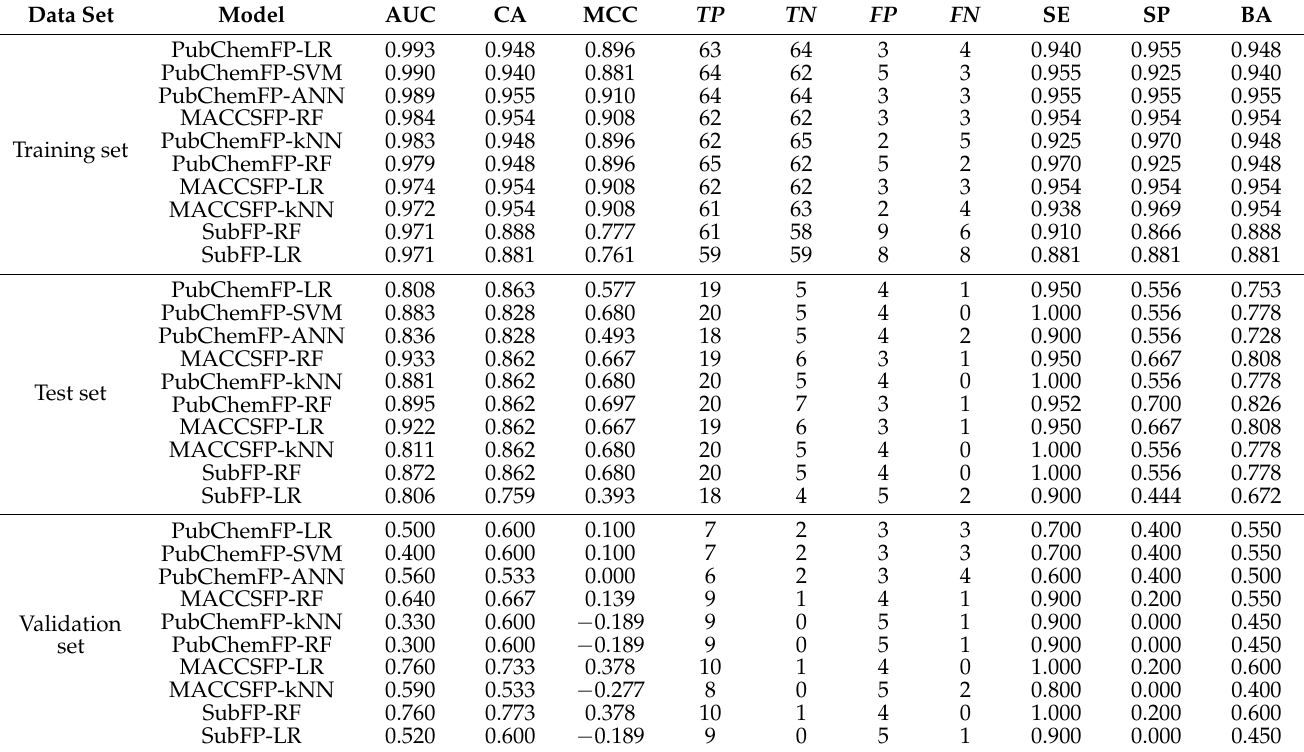
Table 2. Performance of top 10 balanced models for the training set, test set, and external valida- tion